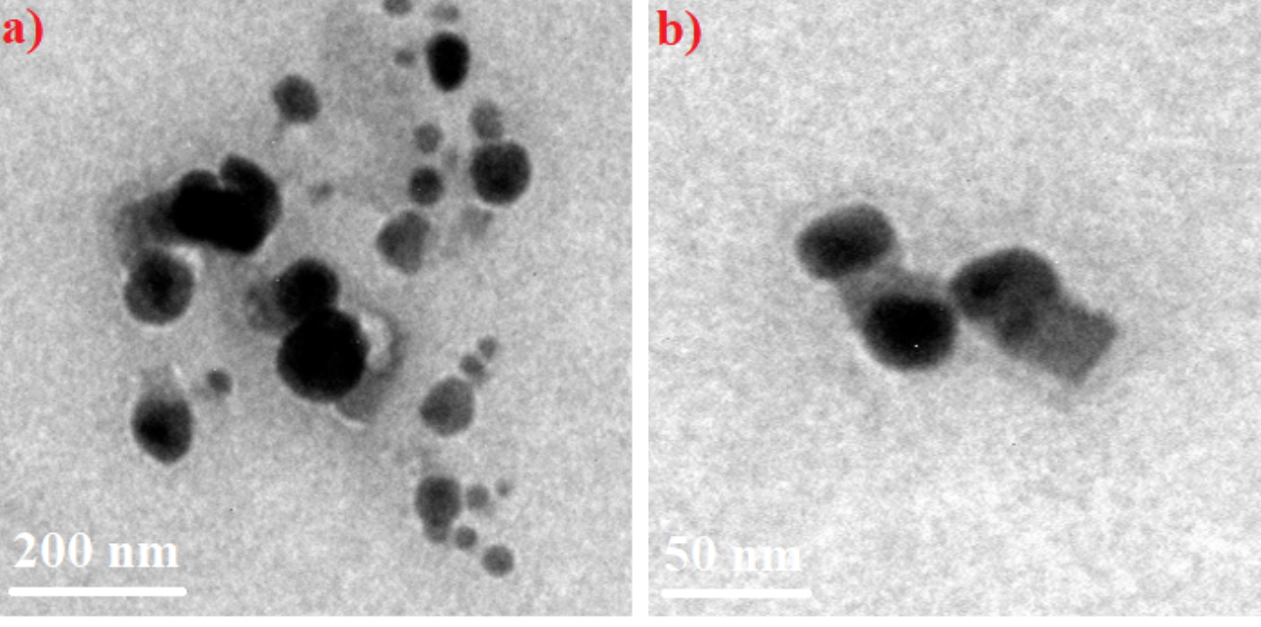
Figure 7. Different magnification (( a )-200 nm and ( b )-50 nm) TEM images of biosynthesized CoFe 2 O 4 nanoparticles.